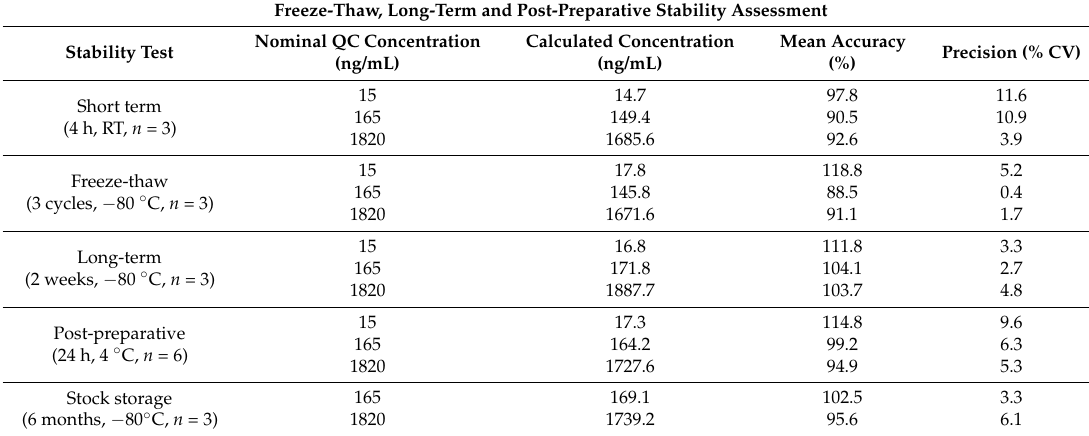
Table 3. Preliminary stability results for